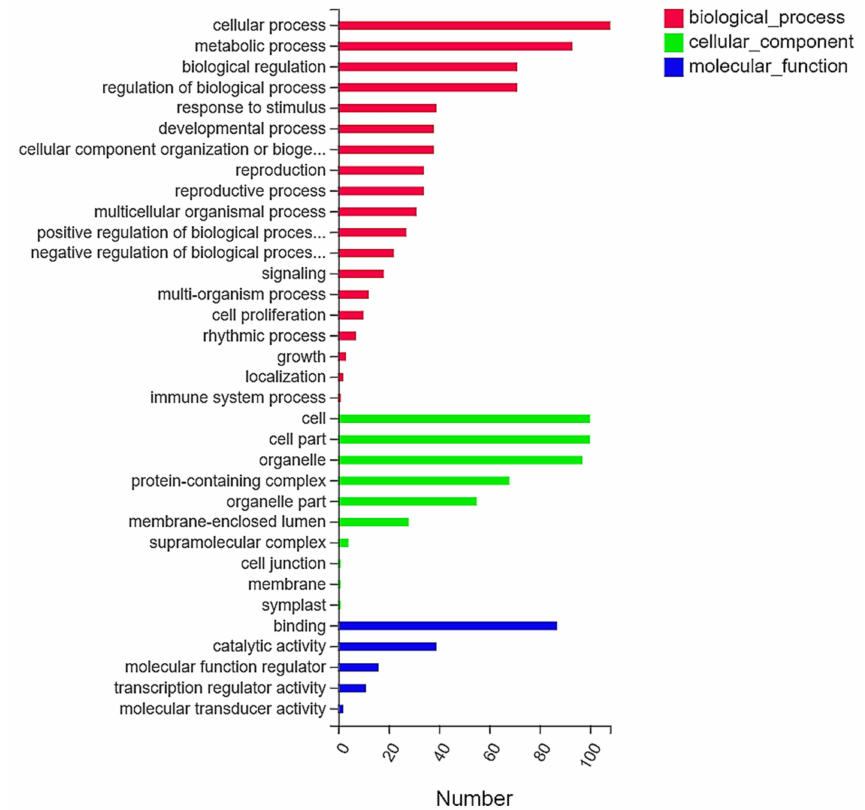
Figure 4. Gene ontology categories of